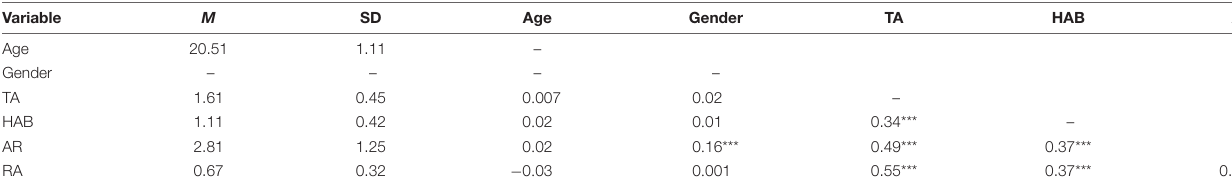
TABLE 1 | The results of descriptive statistics and correlation analysis ( N = 600).